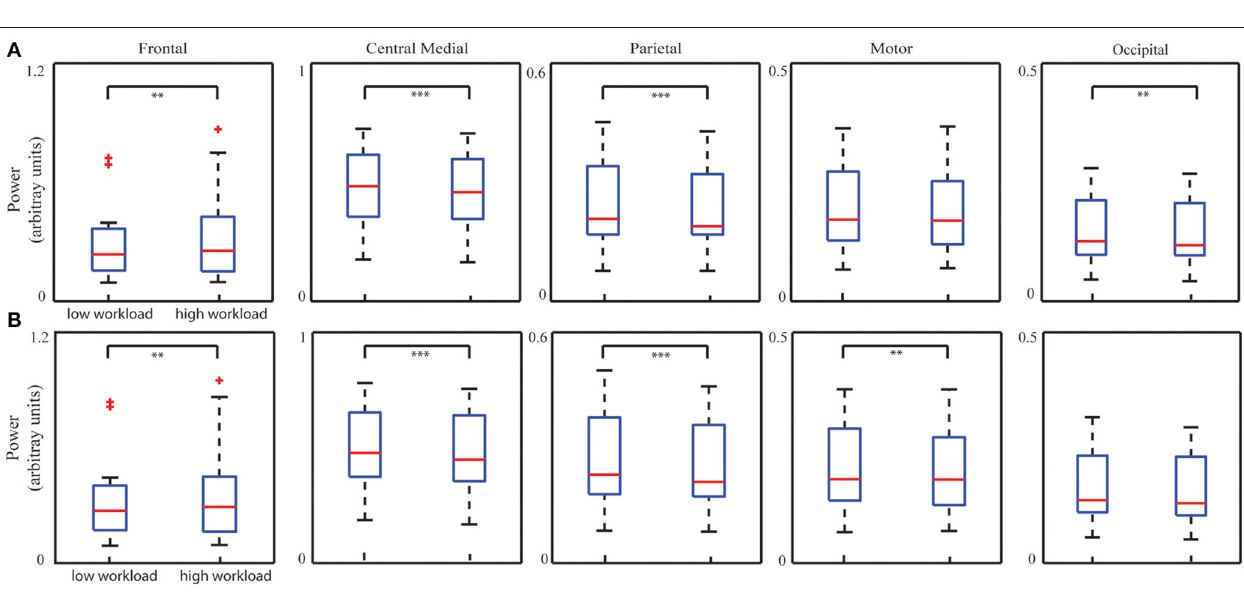
FIGURE 6 | Whisker plots of averaged IC PSDs at corresponding dominant freqency bands from all the sessions of all subjects in low and high mental workload conditions with (A) or without (B) removing TOT-related PSD changes. ** p < 0.01, and *** p < 0.001,